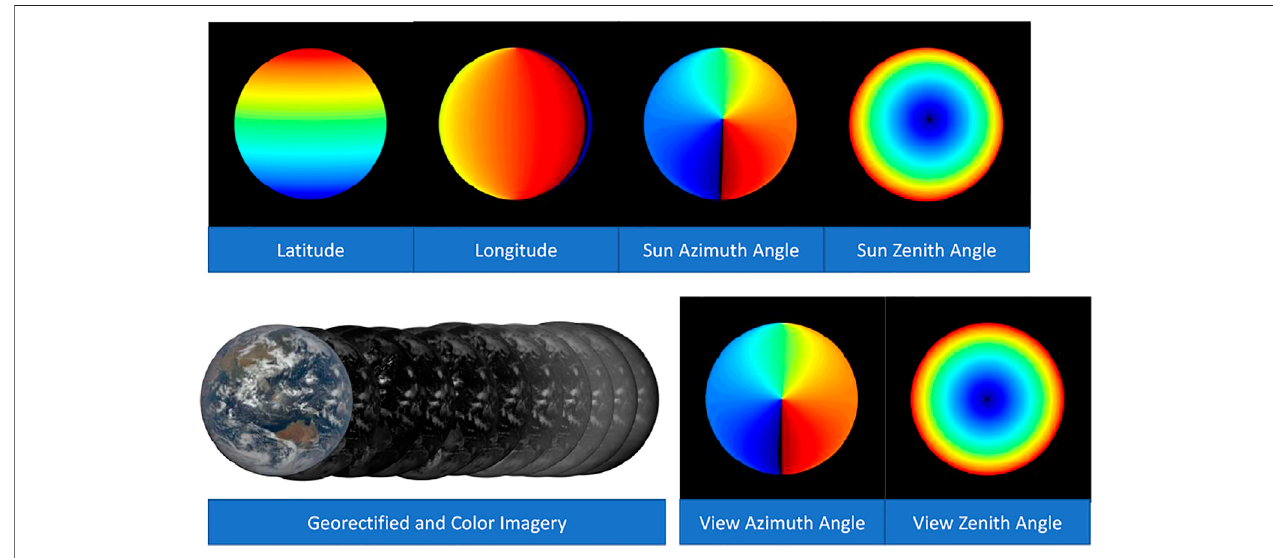
FIGURE 2 | Examples of EPIC geolocation